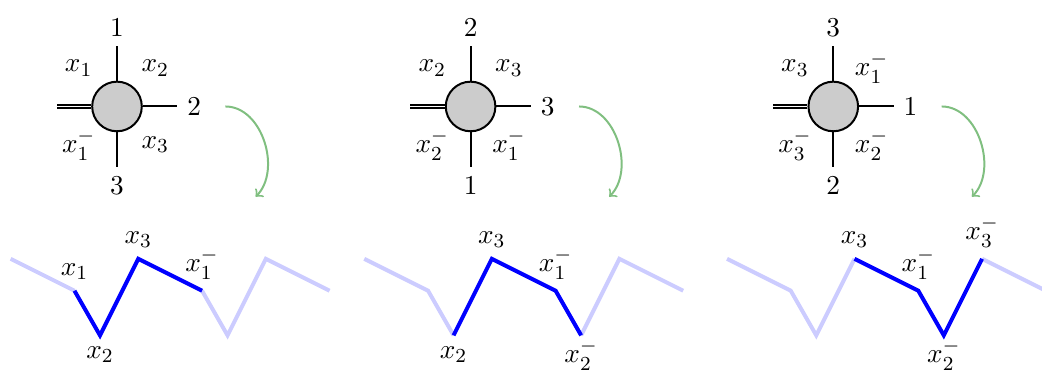
Figure 2. Form factor with three external legs and periodic dual con(cid:12)guration. The highlighted region is the one we